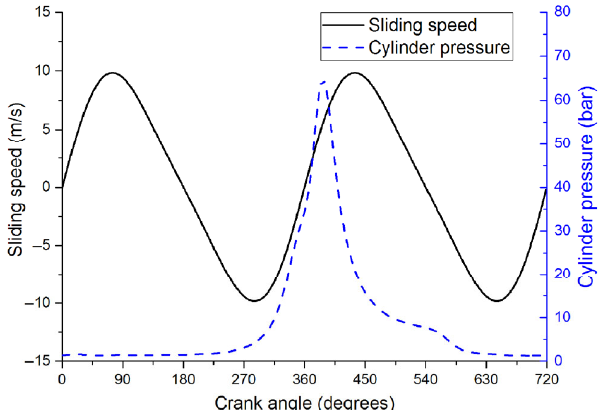
Fig. 3 The variations of sliding speed and cylinder pressure with crank angle.